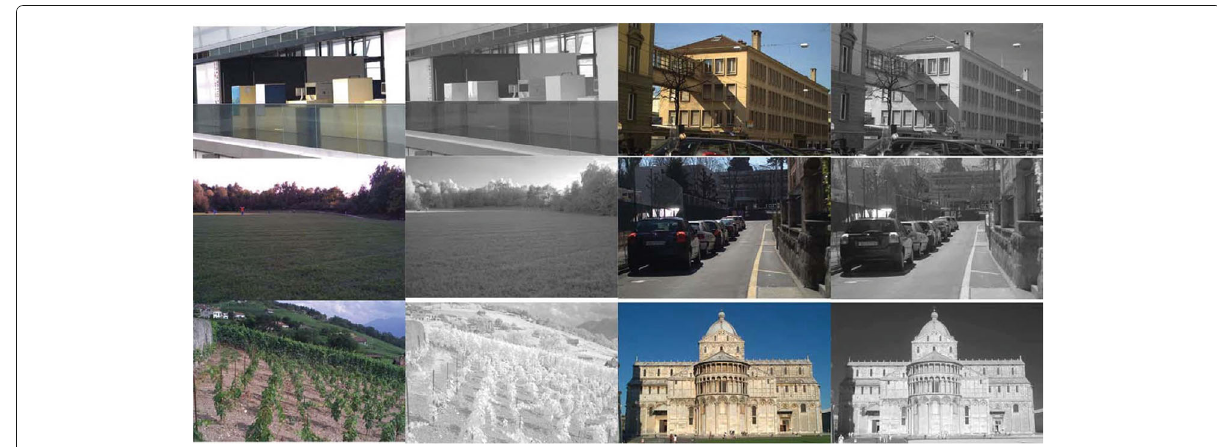
Fig. 3 Examples from EPFL database, each example includes visible image and its corresponding NIR image